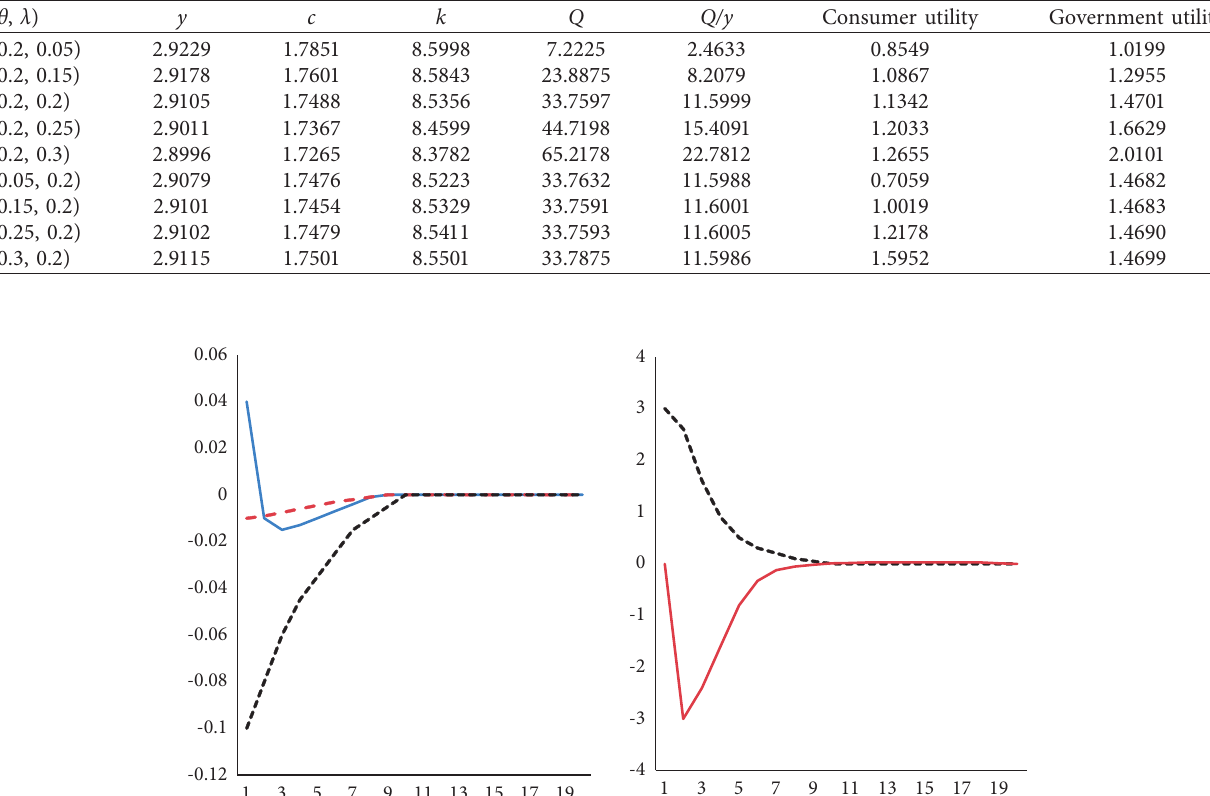
Table 3: The steady-state value and utility value of variables under different